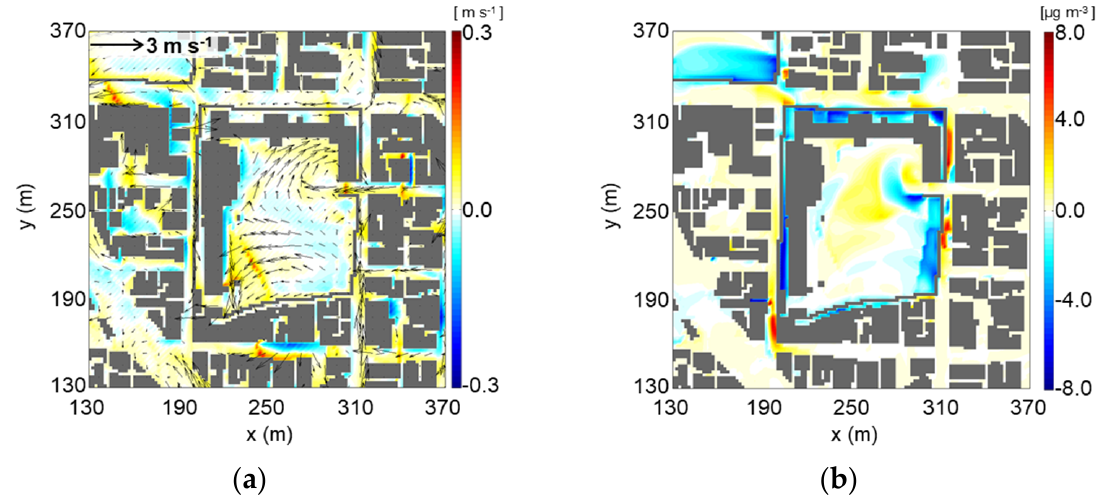
Figure 8. For the east–southeasterly inflow, ( a ) wind vectors and shading of the vertical velocity distribution in the W4M case and ( b ) the difference in PM 2.5 concentrations of the W4M case com ‐ pared to the CNTL case at 1 m above the ground.